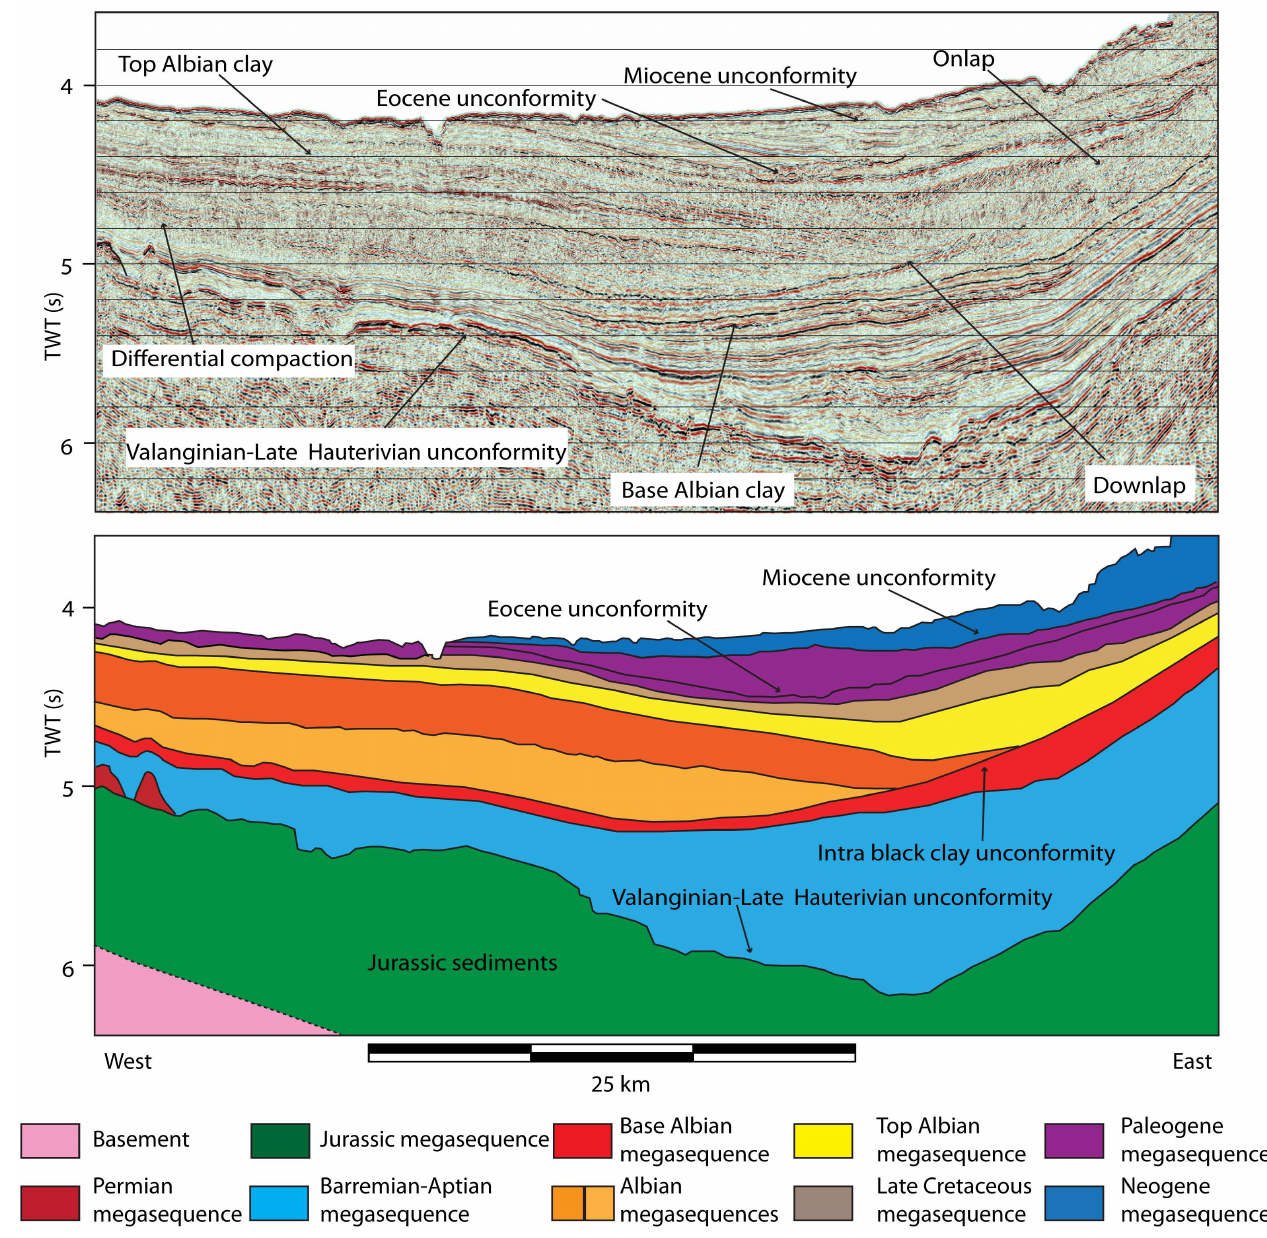
Fig. 7. (A) Uninterpreted and (B) interpreted seismic line showing the seismic characteristics and architecture of megasequences within the central Mentelle